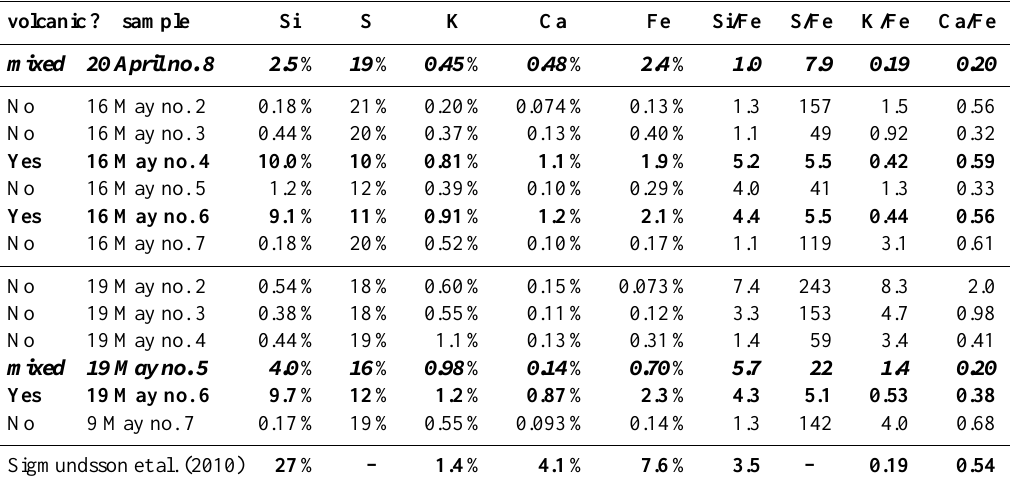
Table 2. Relative mass contents and mass ratios of those elements that were enhanced in the volcanic ash samples collected by the aerosol impactor sampler during the three CARIBIC volcano flights. The samples containing volcanic ash are marked in bold. Sample 8 on 20 April and sample 5 on 19 May probably represent a mixture of air with and without volcanic influence and are therefore shown in bold italics. The values derived from Sigmundsson et al. (2010) are means for their samples SRG 2b and SRG 5a collected on 15 April and 27 April 2010 in the vicinity of the